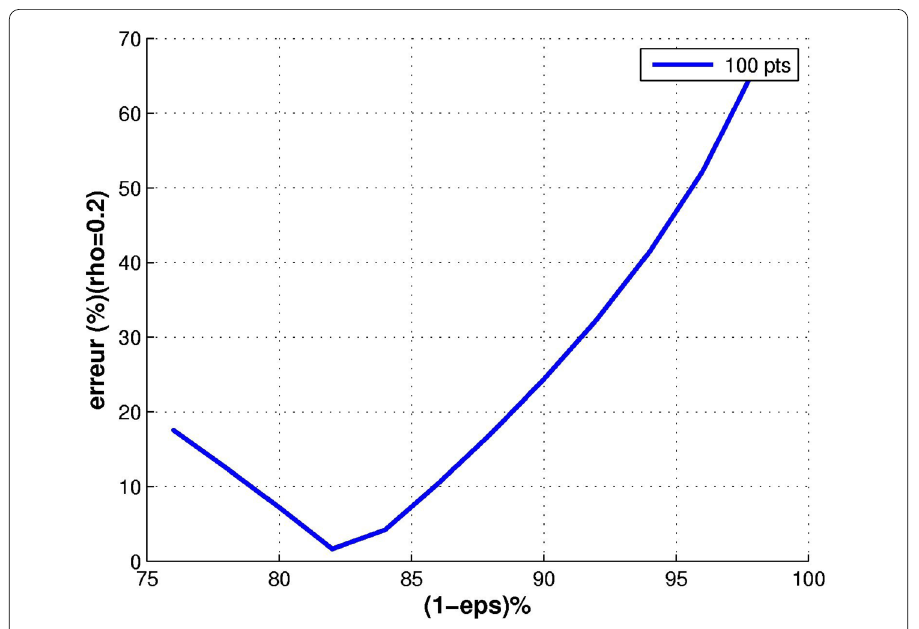
Figure 7 Variation of the error function